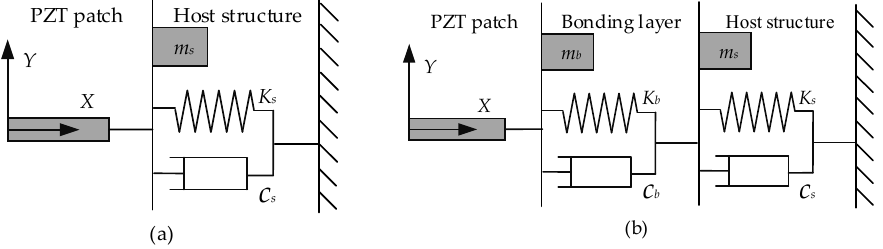
Figure 2. The one-DOF model ( a ) and the two-DOF model ( b ) for the embedded PZT sensors.